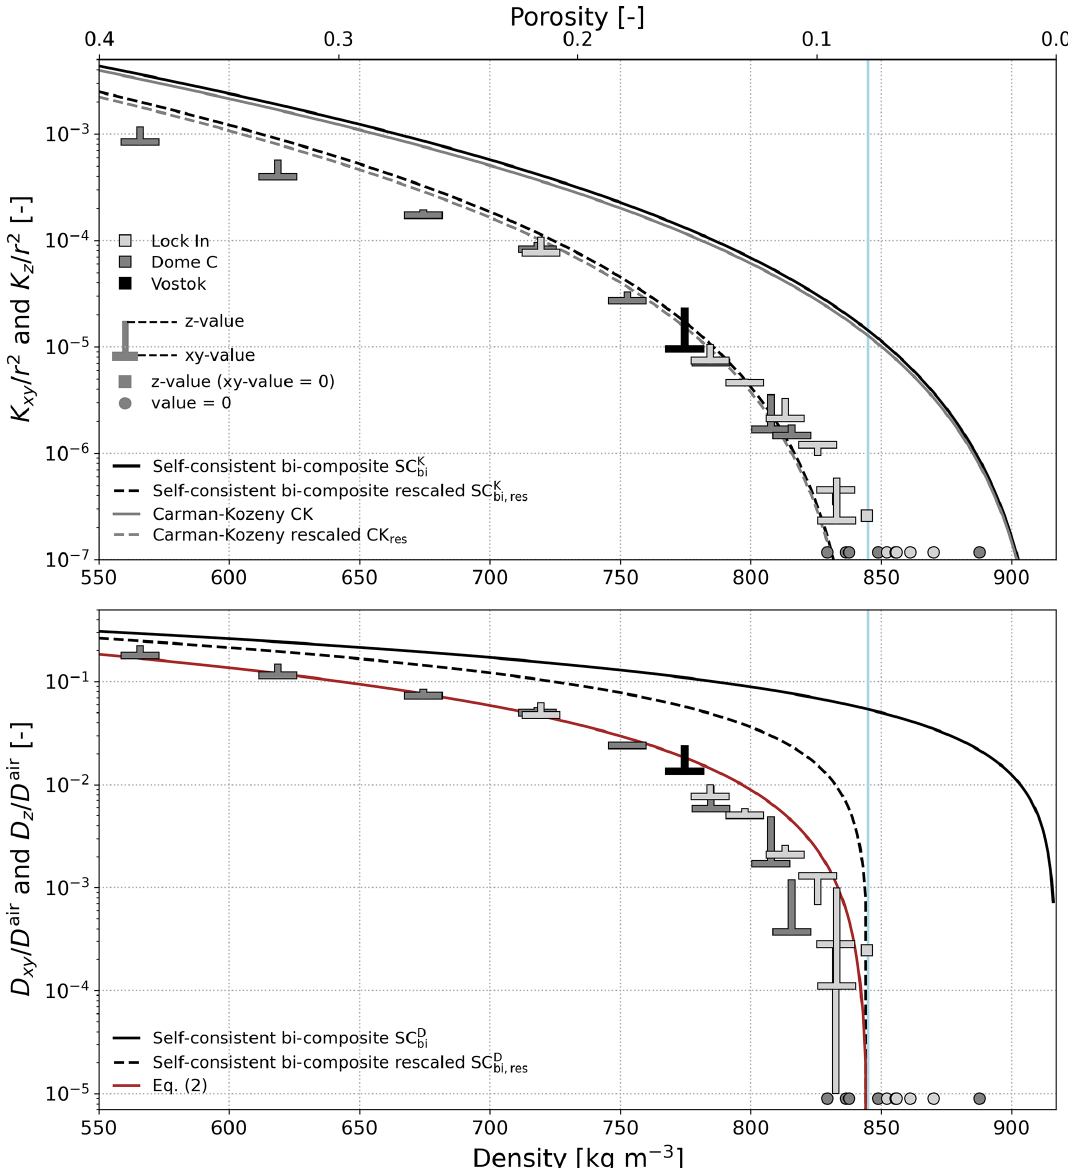
Figure 3. Dimensionless permeability and normalized diffusion coefficient of firn versus density: computations from the 3D images (“T” symbols) and analytical models (lines). The proposed regression Eq. (2) is also shown. The vertical blue lines at 845kgm − 3 indicate the close-off